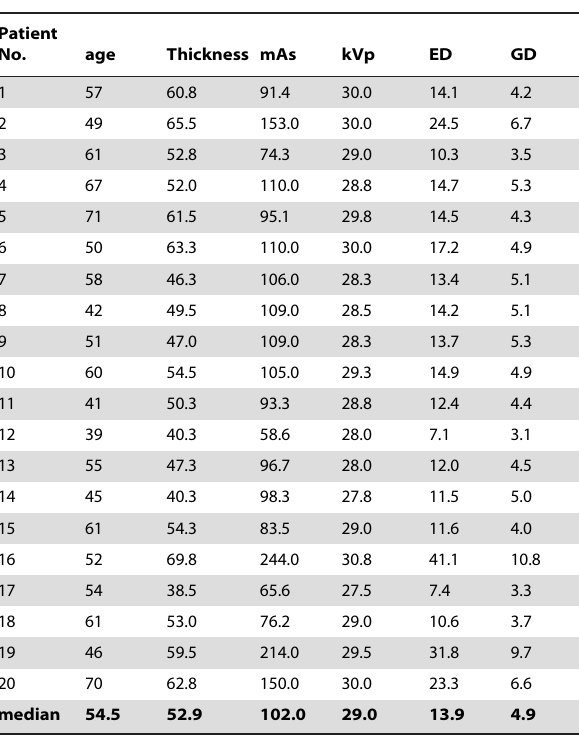
Table 1. Patients with two view mammography of both breasts: patient’s age in years (age), mean compression thickness in cm (thickness), mean tube current time product in mAs (mAs), mean tube voltage in kV (kVp), total entrance dose of four views in mGy (ED), total glandular dose of four views in mGy